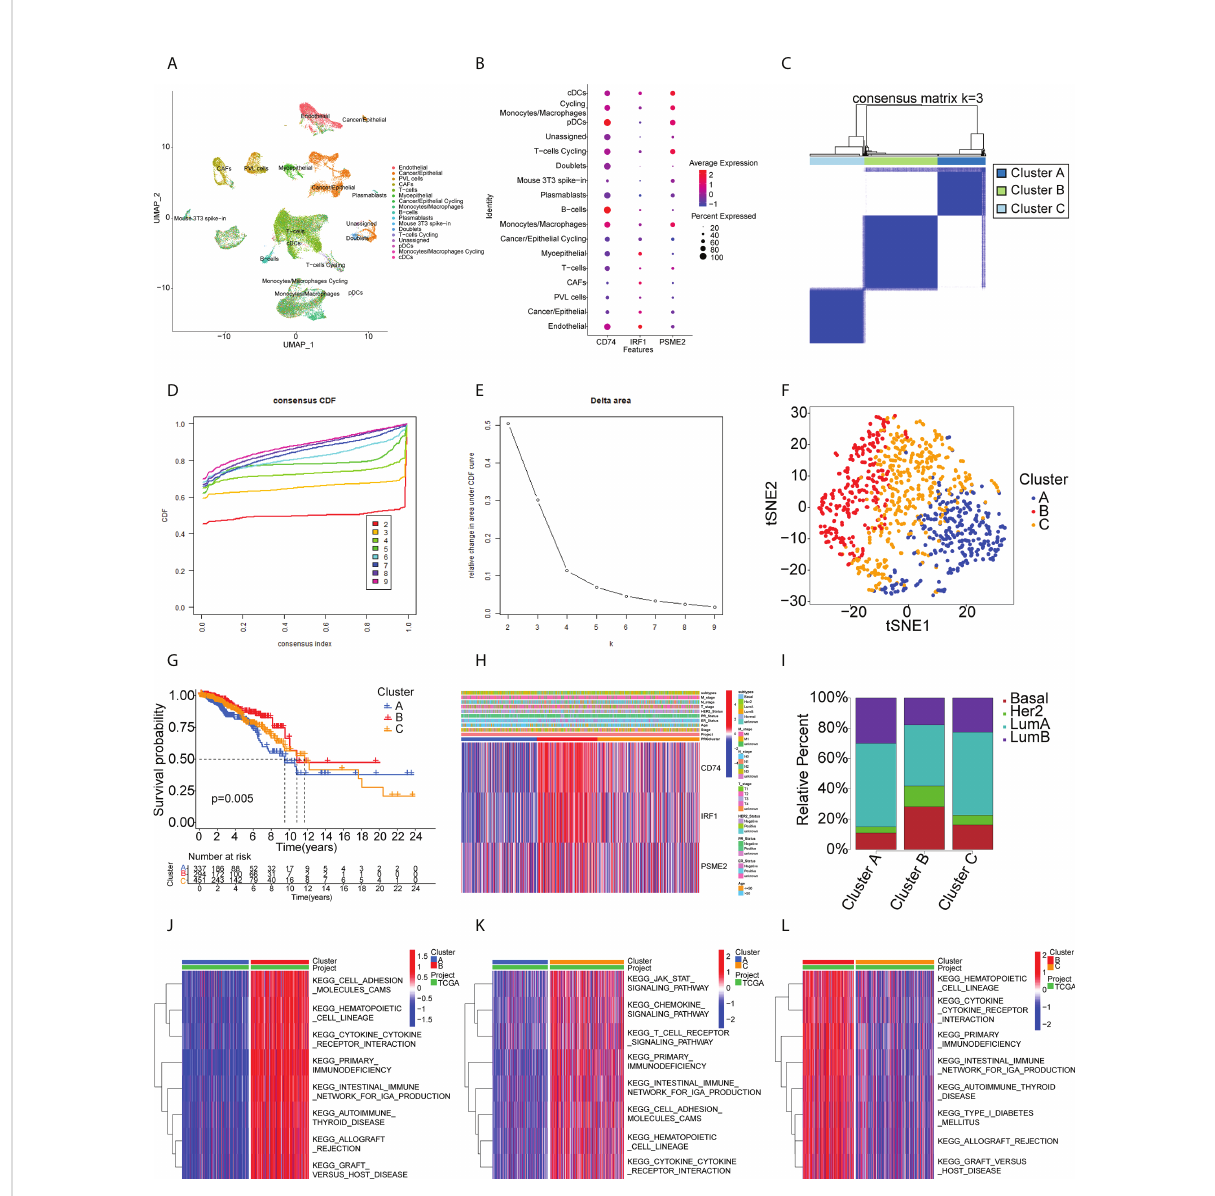
FIGURE 3 Single-cell transcriptomic pro fi les from 17 cell subtypes from 3 BC patients and immune clusters of BC patients in the TCGA cohort. (A) 2d visualization of 17 cell subtypes in 3 BC patients on the UMAP plot. (B) the expression of CD74, IRF1, PSME2 in 17 cell types was visualized by bubble plot. (C-E) Three clusters of patients in the TCGA cohort divided according to levels of prognostic immune-related genes. (F) t- distributed stochastic neighbor embedding (t-SNE) analysis of distributions in the clusters. (G) Survival analysis in the clusters. (H) Heatmap of tumor antigen expression and clinical parameters. (I) Distribution of immune clusters in patients with different subtypes. (J-L) GSVA enrichment analysis showing pathway activation in the clusters. Red color in the heatmap presents pathway activation and blue color represents pathway